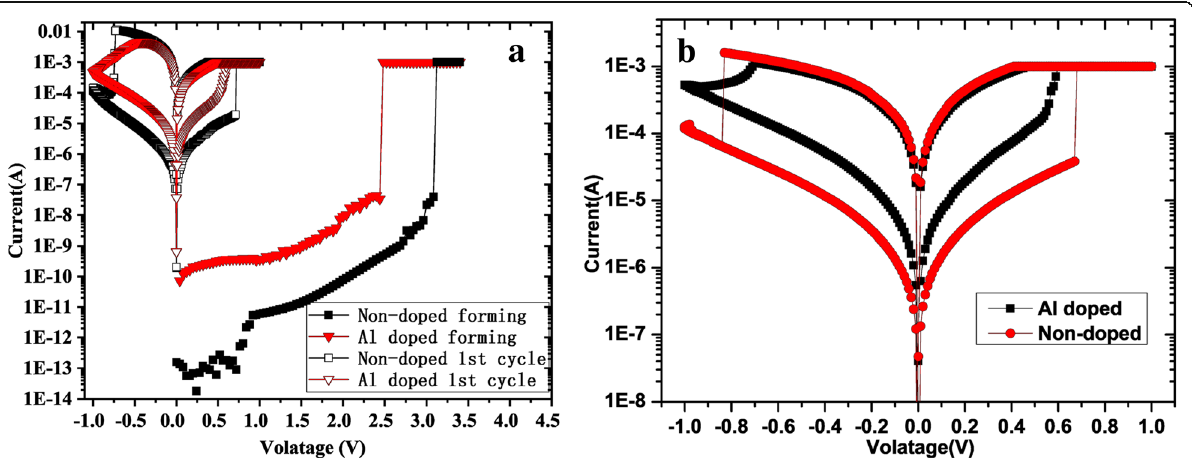
Fig. 3 The I/V characteristics of the devices. a The forming process and first cycle. b The typical set/reset process